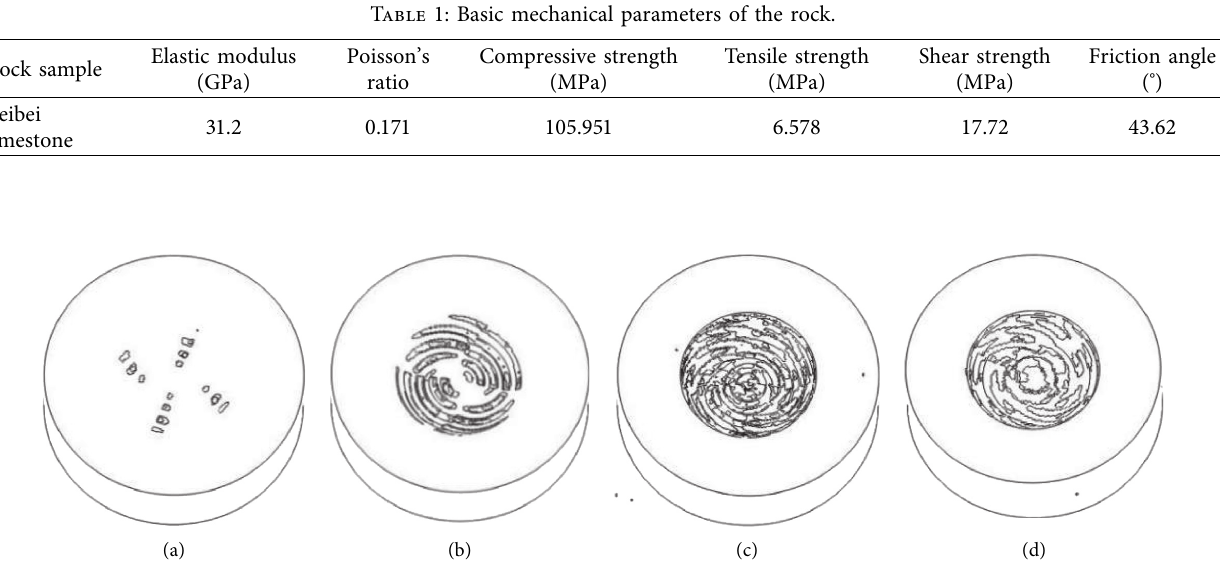
Figure 11: Bottom-hole patterns in different times. (a) t � 0.05 s, (b) t � 0.6 s, (c) t � 2s, and (d) t � 4 s.